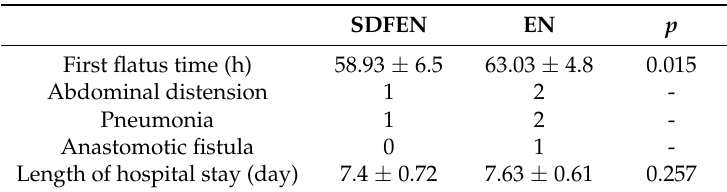
Table 6. Post-operative